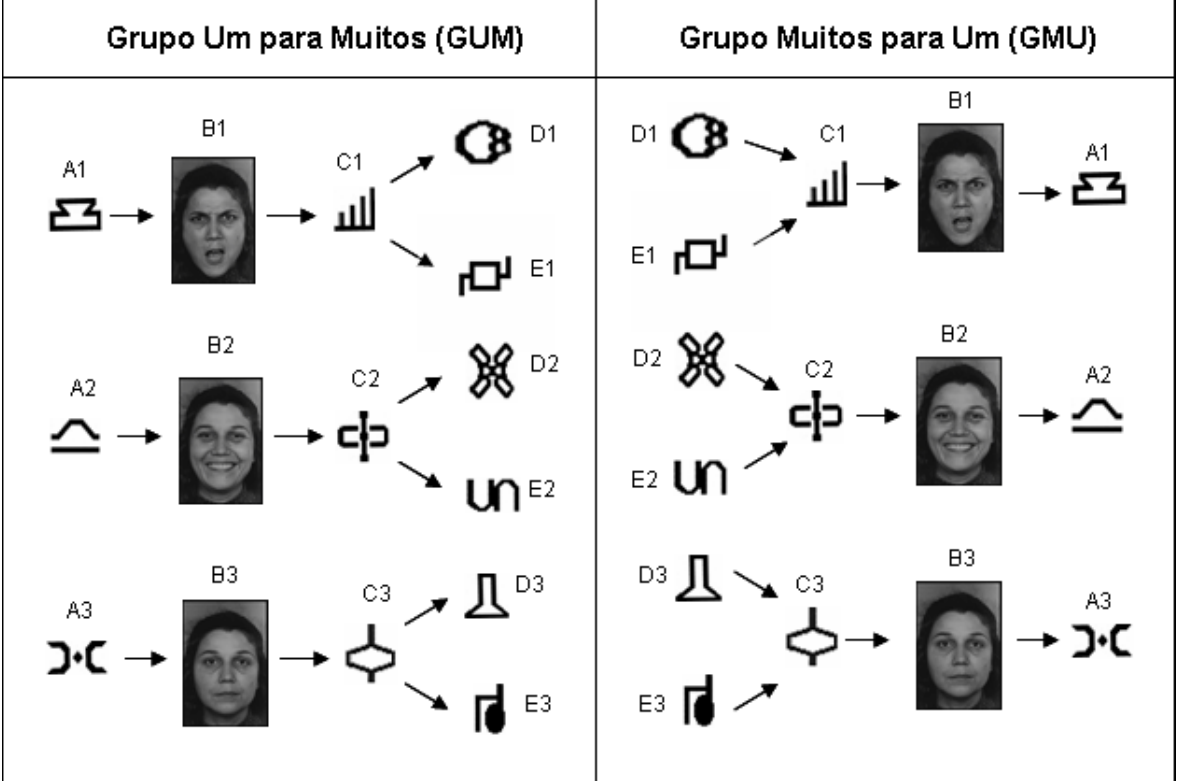
Figura 1 . Diagrama esquemático da estrutura dos procedimentos de ensino para cada grupo